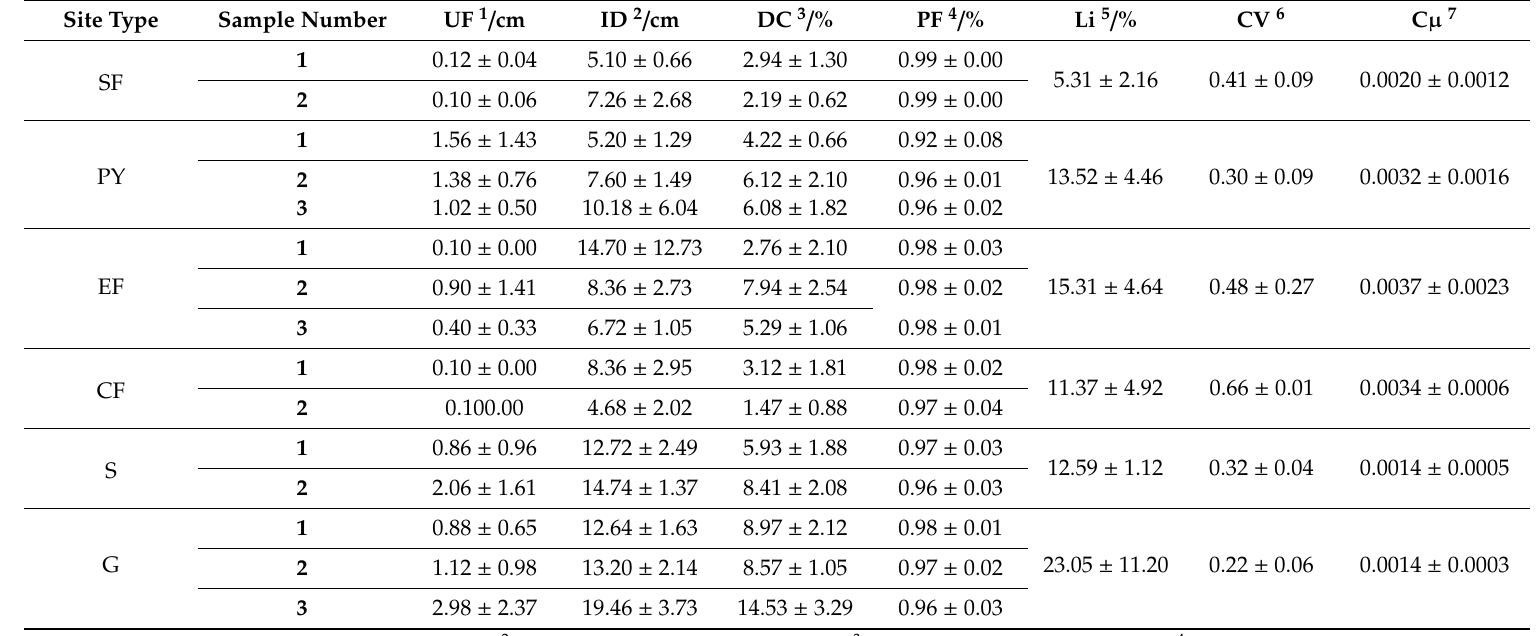
Table 2. Characteristic parameters of preferential flow variables. (G5). (average value ± standard